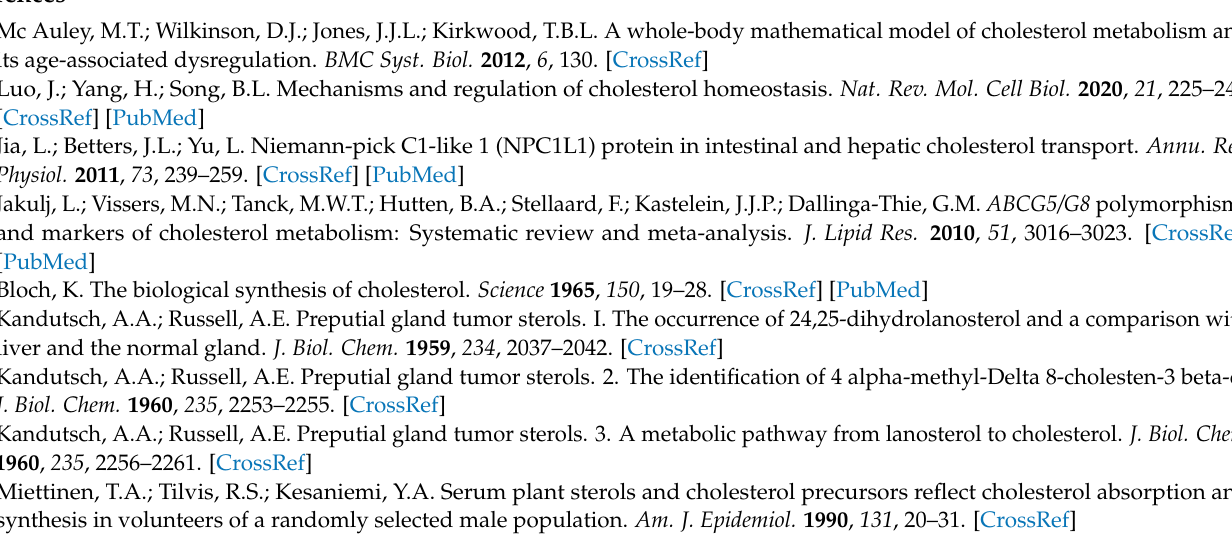
pathway, Figure S2: The endogenous cholesterol synthesis pathway, Table S1: List of full names of genes included in the present study, Table S2: Information given by the Precision Medicine Research Array for the two SNPs in ABCG8 with an unknown rs-number, Table S3: Baseline characteristics for all participants and stratified by study, Table S4: Associations between intestinal cholesterol absorption markers, an endogenous cholesterol synthesis marker and serum LDL-C concentrations, Table S5: The location and allele frequencies for various SNPs in intestinal cholesterol absorption and endogenous cholesterol synthesis genes for 456 participants, Figure S3: Pairwise LD among SNPs in ABCG5 and NPC1L1 , Figure S4: Pairwise LD among SNPs in MSMO1 , DHCR7 , DHCR24 , and LBR , Table S6: Associations between various SNPs in cholesterol absorption genes, that were either captured by a tag SNP or contained a genotype group < 12 individuals, with serum TC-standardized campesterol, sitosterol and lathosterol levels (N = 455), and serum LDL-C concentrations (N = 456), Figure S5: Association between SNPs NPC1L1 (rs127429) and NPC1L1 (rs217416) with serum levels of cholesterol-standardized lathosterol using recessive models, Table S7: Associations between SNPs in intestinal cholesterol absorption genes with TC-standardized non-cholesterol sterols using additive models (N = 455), Table S8: Associations between various SNPs in genes involved in intestinal cholesterol absorption with serum total cholesterol concentrations (N = 456), Figure S6: Association between SNPs HMGCR (rs12916) and LBR (rs12141732) with serum LDL-C concentrations using dominant models, Table S9: Associations between various SNPs in endogenous cholesterol synthesis genes, that were either captured by a tag SNP or contained a genotype group < 12 individuals, with serum TC-standardized campesterol, sitosterol and lathosterol levels (N = 455), and serum LDL-C concentrations (N = 456), Table S10: Associations between various SNPs in genes involved in endogenous cholesterol synthesis with serum total cholesterol concentrations (N =